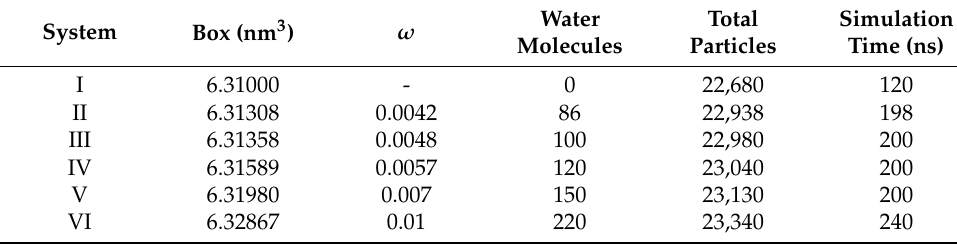
Figure 6. Intra-diffusion coefficient of water calculated from mean square displacement of molecular dynamics simulations at different water concentration. Table 1. Systems composition and simulation